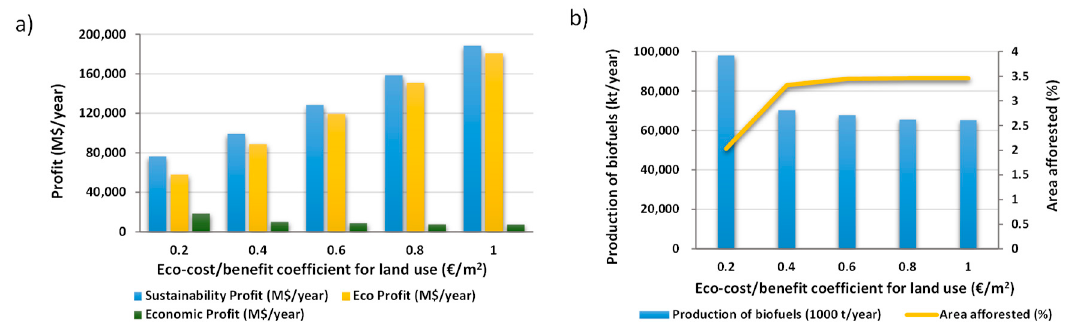
Figure 11. Influence of eco cost/benefit coefficient for additional land use on ( a ) economic, eco, and sustainability profit and ( b ) production of biofuels and percentage of afforested